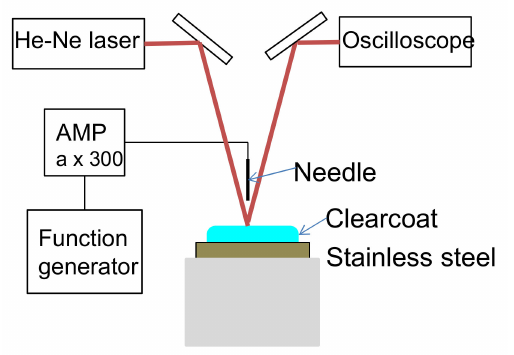
Figure 3. Electric-field tweezers